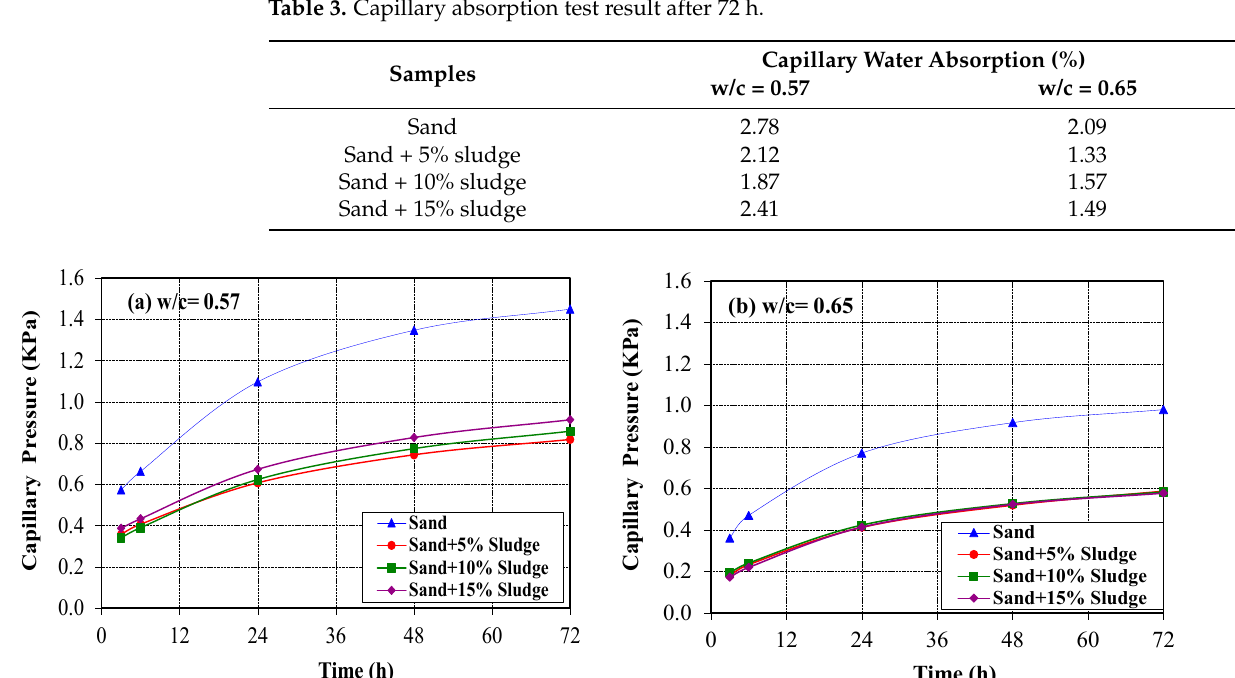
Figure 9. Capillary water absorption pressure versus time, with conventional concrete and concrete with sewage sludge: ( a ) for the ratio w/c = 0.57; and ( b ) for the ratio w/c = 0.65.